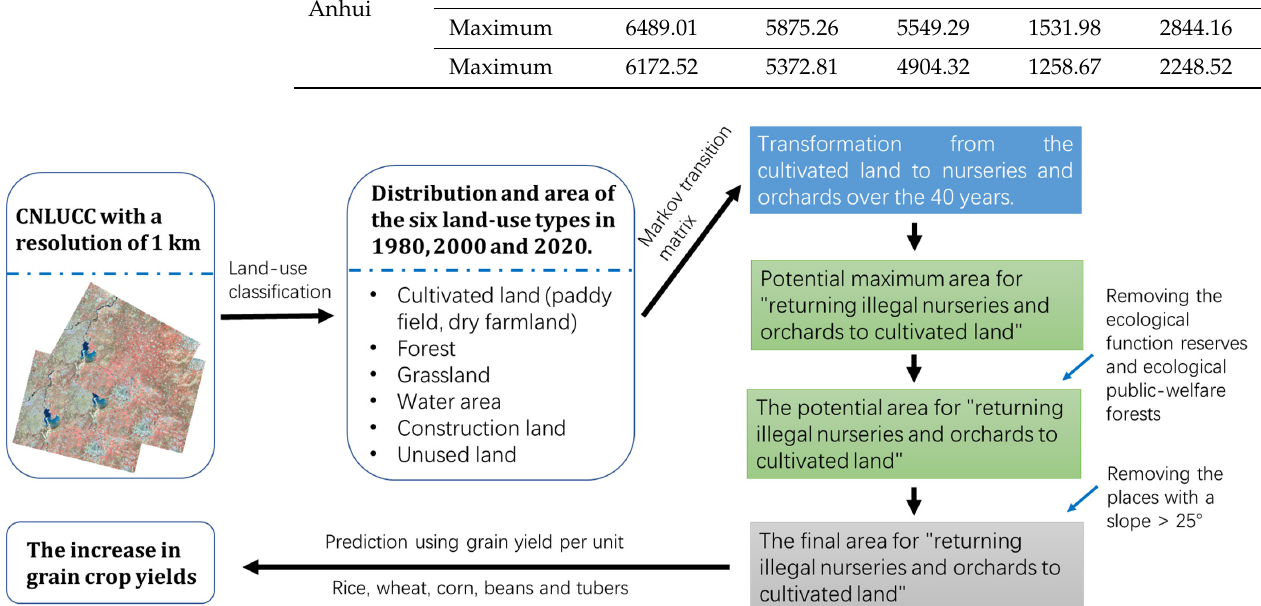
Figure 2. A flowchart of data analysis. Table 2. Grain yield per unit area in the Yangtze River Delta region over the past 10 years (2010- 2020) in the China Statistical Yearbook (kg/ha).